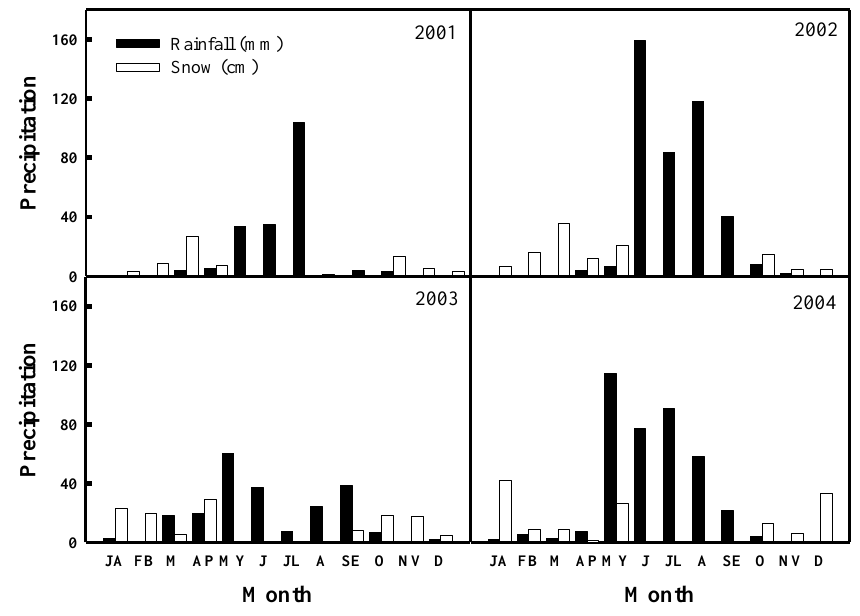
Fig. 2 638 Fig. 2. Mean monthly precipitation at the study site during four consecutive years (2001–2004). Source: Environment